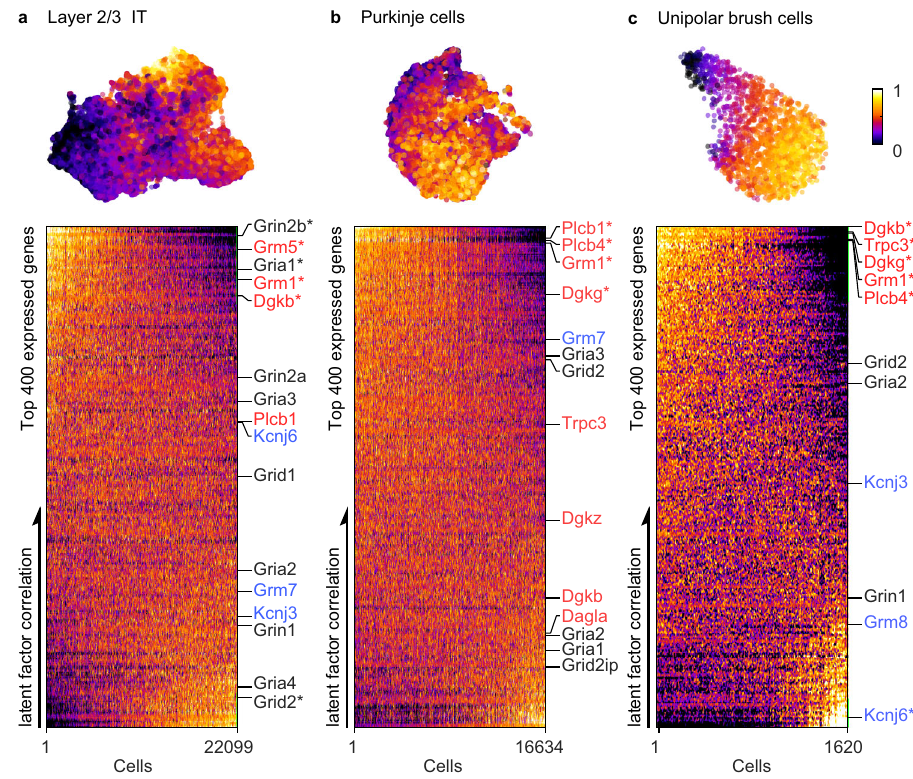
Fig. 1 Graded continuum of molecular properties in different cell types. a (Top) UMAP embedding showing the latent factor in cortical layer 2/3 intratelencephalic (IT) neurons. (Bottom) Heatmap of normalized gene expressions (top 400) ordered by increasing correlation with the latent factor (vertical axis). The cells are sorted in the order of decreasing factor loading (horizontal axis). All genes involved in glutamatergic synaptic transmission are shown to the right. Ionotropic receptors are shown in black, Group I metabotropic receptors and associated proteins are highlighted in red; and Group II/III metabotropic receptors and associated proteins are shown in blue. The most differentially expressed genes are denoted with an asterisk (top 1% Pearson R). b Same analysis for cerebellar Purkinje cells. c Same analysis for cerebellar unipolar brush cells